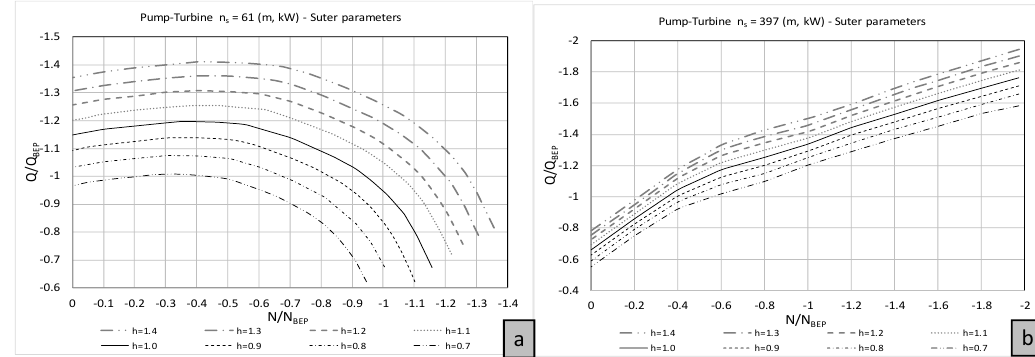
Figure 5. Q / Q BEP as function of N / N BEP and h for ( a ) radial and ( b ) axial machine (adapted from [47–49]).